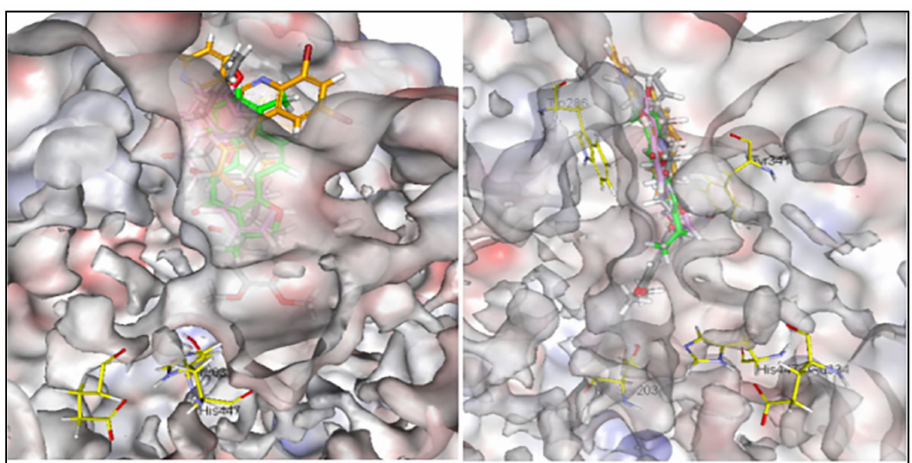
Figure 5. Alignments of DHI (green), donepezil (grey), 5,7-dihydroxy-2-phenyl-4H-chromen-4-one (pink) and 4-phenyl-2-(pyridin-3 yl)quinazoline (orange) in the active site of AChE (Left: face view, Right: side view).